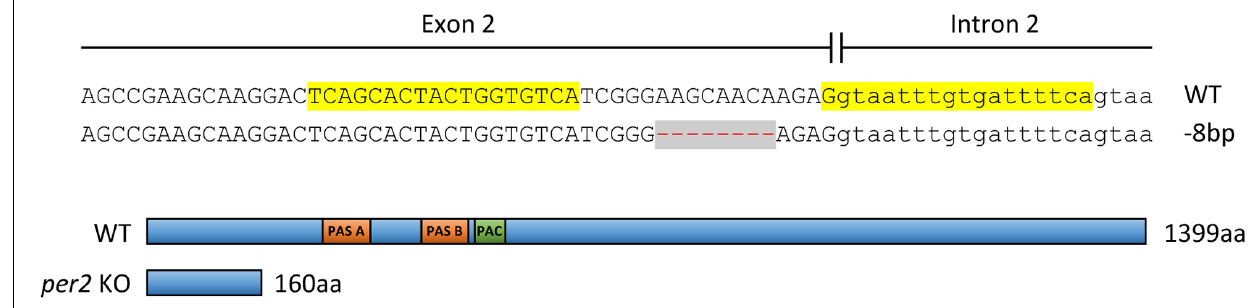
Frontiers in Molecular Neuroscience |